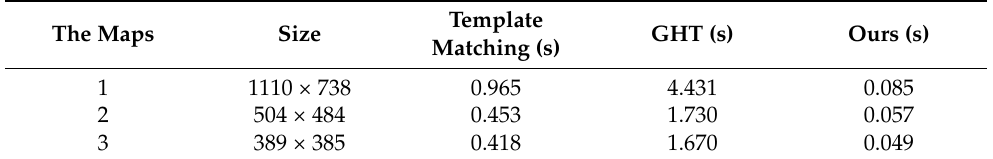
Table 5. The inference time of different methods.